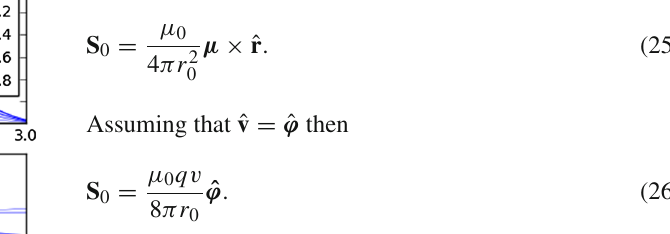
S (cid:8)(cid:8) + f 1 ( x ; α) S = 0